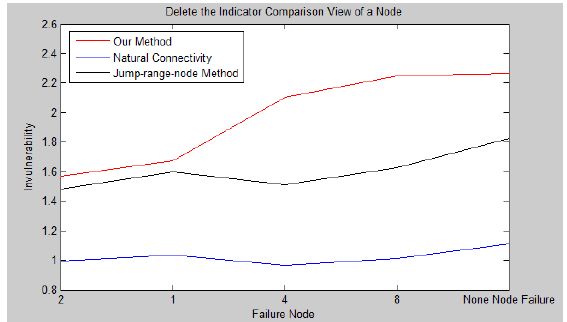
Figure 8. Indicator Comparison after Deleting a Node.